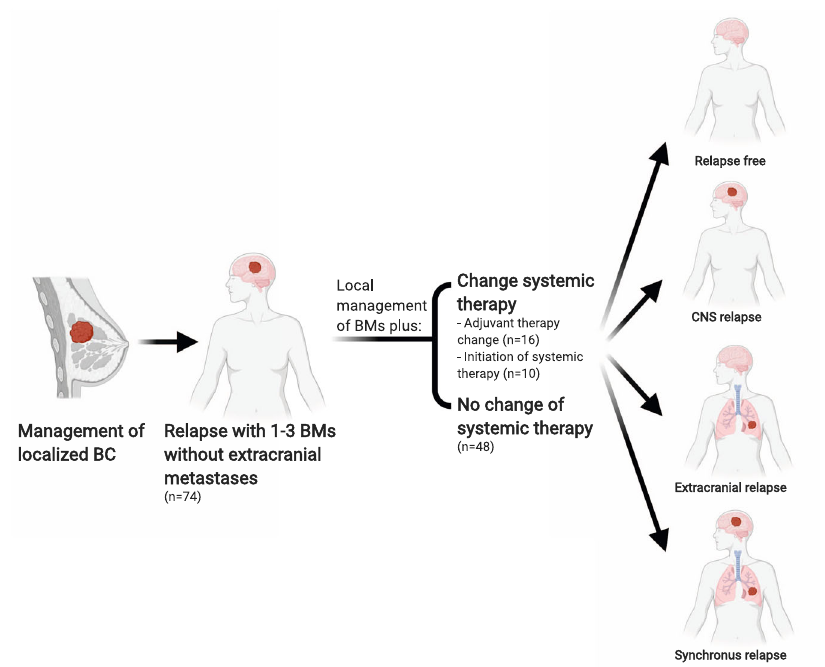
Fig. 1 Clinical scenarios of analyzed patients. BC, breast cancer. BM, brain metastases. CNS, central nervous